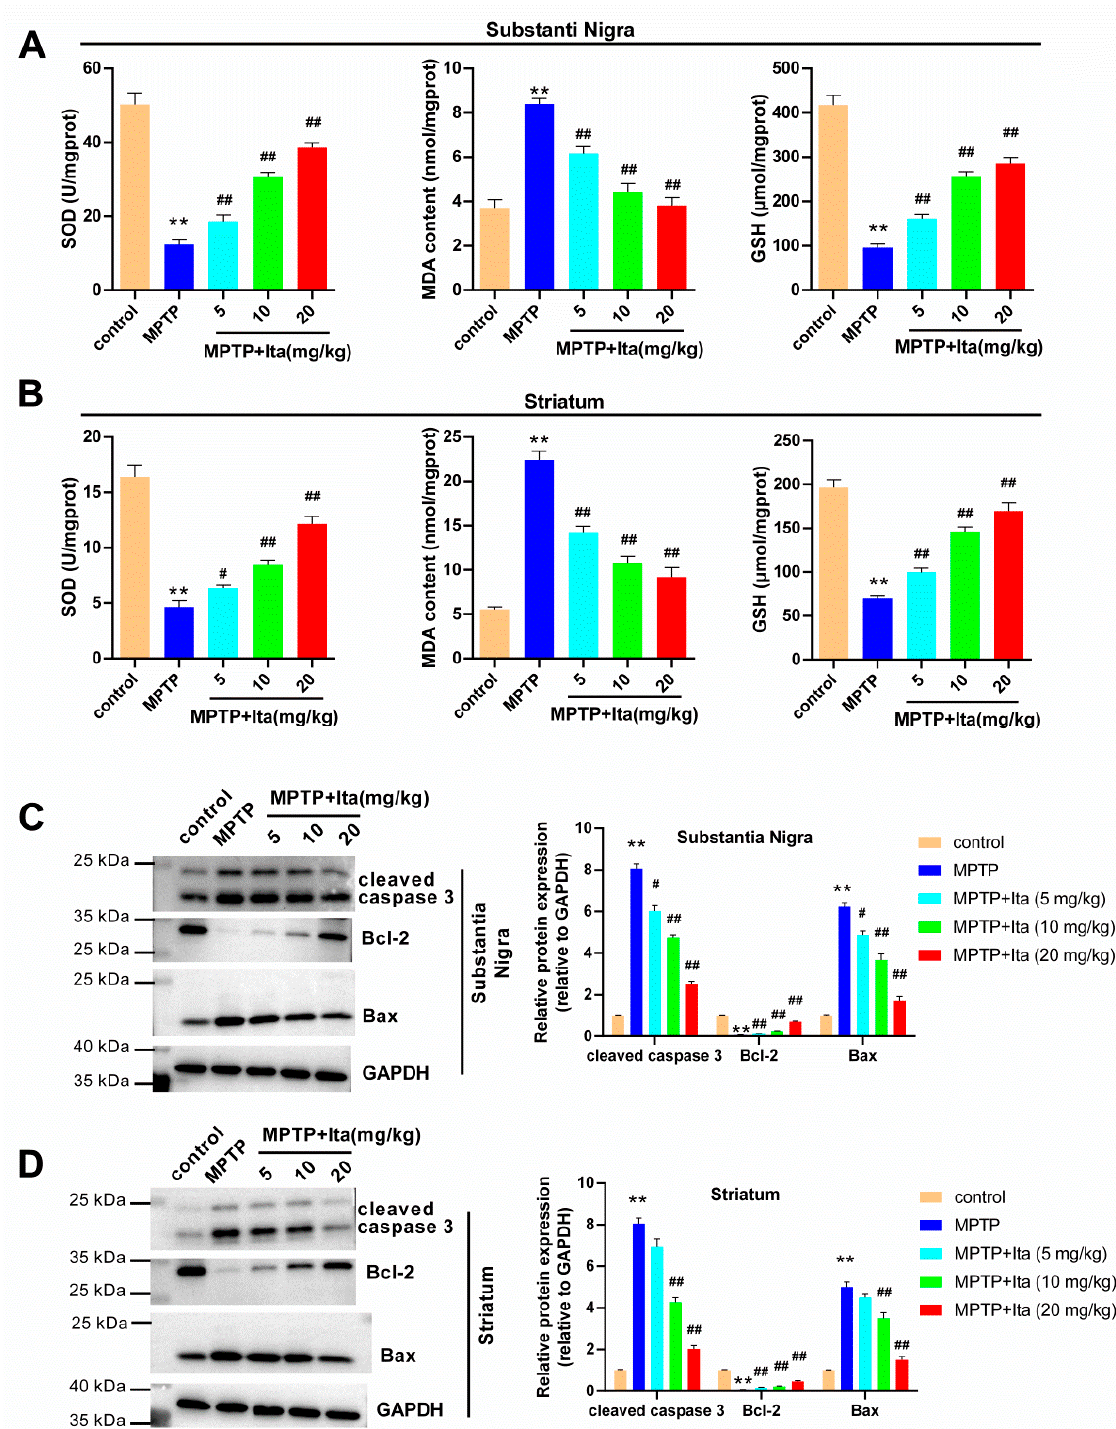
Figure 3. Itaconate attenuated oxidative stress and apoptosis in MPTP-induced PD mice. SOD, MDA, and GSH content were detected using their corresponding commercial kits in substantia nigra ( A ) and striatum ( B ). The protein expression of cleaved caspase 3, Bcl-2, and Bax in substantia nigra ( C ) and striatum ( D ) was analyzed using Western blotting. GAPDH serves as an internal control. n = 5. ** p < 0.01 vs. control group; # p < 0.05, ## p < 0.01 vs. MPTP group. GAPDH, glyceraldehyde-3-phosphate dehydrogenase; Bcl-2, B cell lymphoma-2; Bax, BCL-2 associated X; Ita, Itaconate.